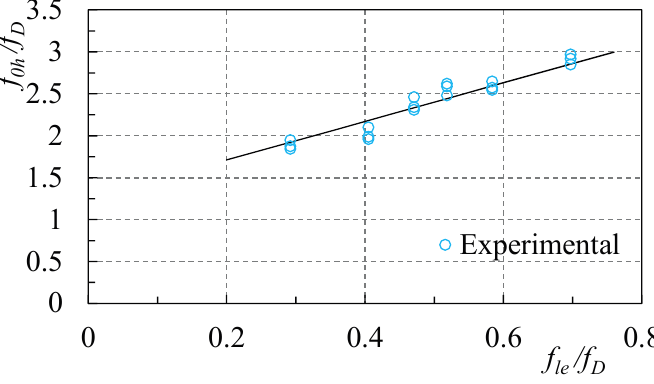
Figure 18. Parameter E 2h -experimental calibration with concrete cylinders confined with GFRP tubes and SR.